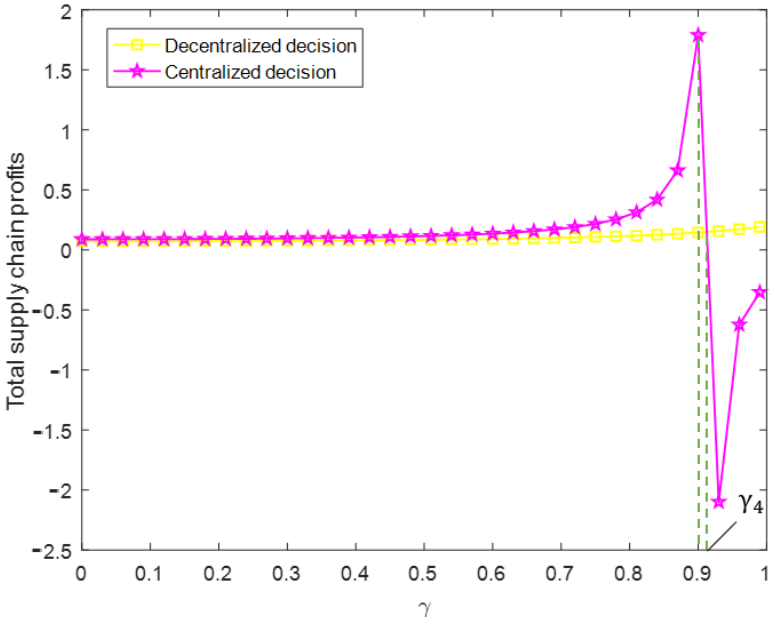
Figure 5. The impact of 𝛾 on total CDW supply chain profit with government subsidies.